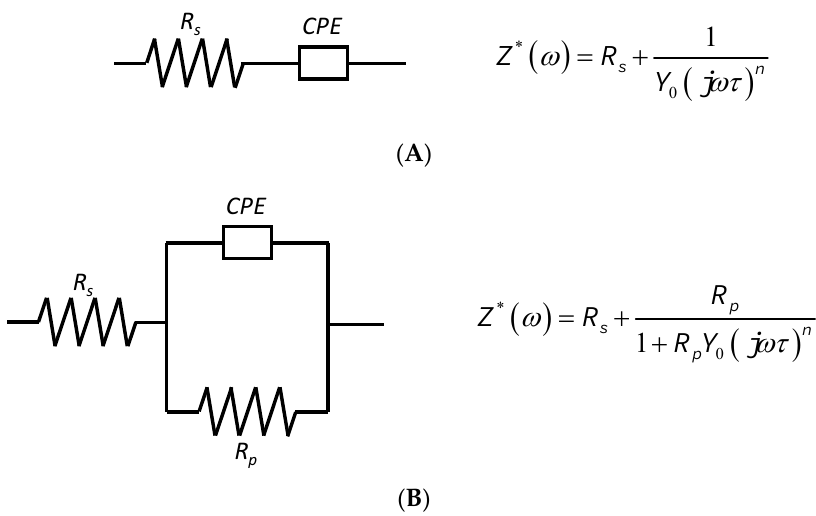
Figure 6. Equivalent circuits used to study the behavior of the PBI composite membranes containing silica nanofillers analyzed in ( A ) dry and ( B ) wet